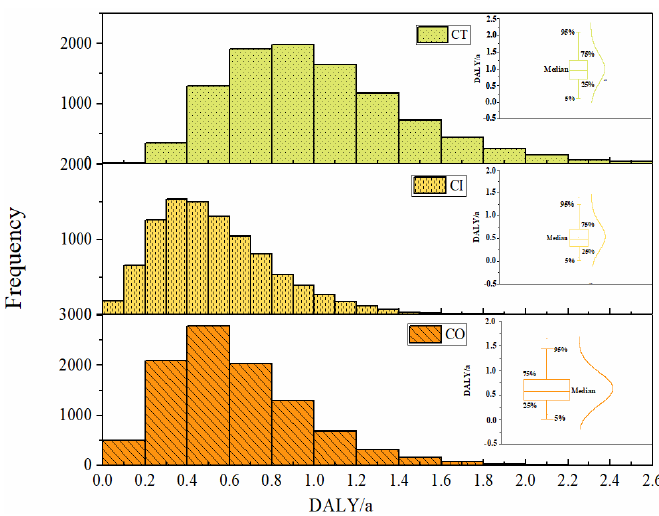
Figure 7. Maize simulation results of the DALY.